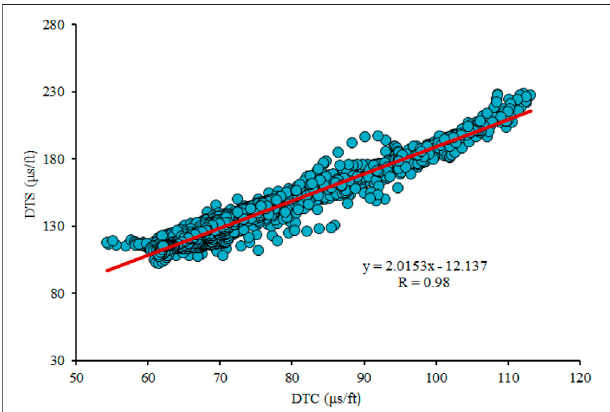
FIGURE2| Relationship betweenlongitudinaland transversewavetime differences obtained by the full-wave array acoustic wave tests. DTC- longitudinal wave time difference; DTS- transverse wave time